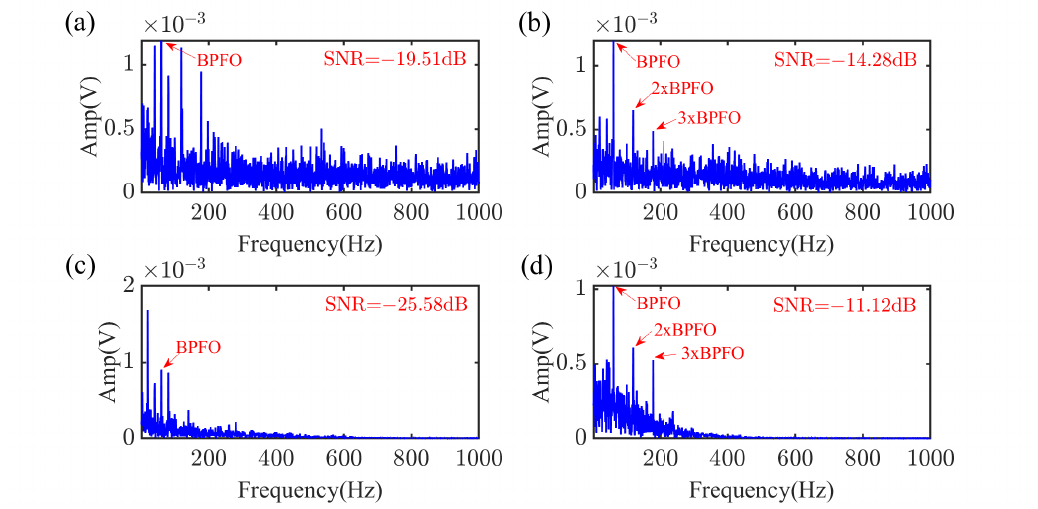
Figure 14. Envelope spectrum analysis results: ( a ) original signal; ( b ) band-pass filter; ( c ) VMD; ( d ) the proposed method.